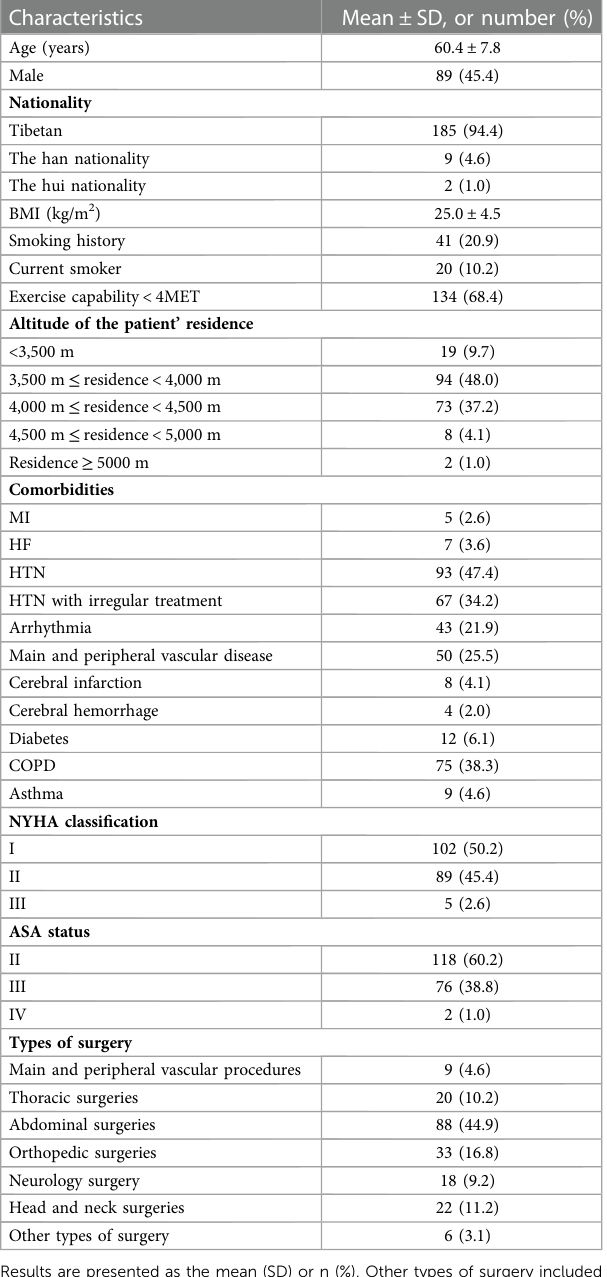
TABLE 1 Demographics and surgery types of the study population ( N